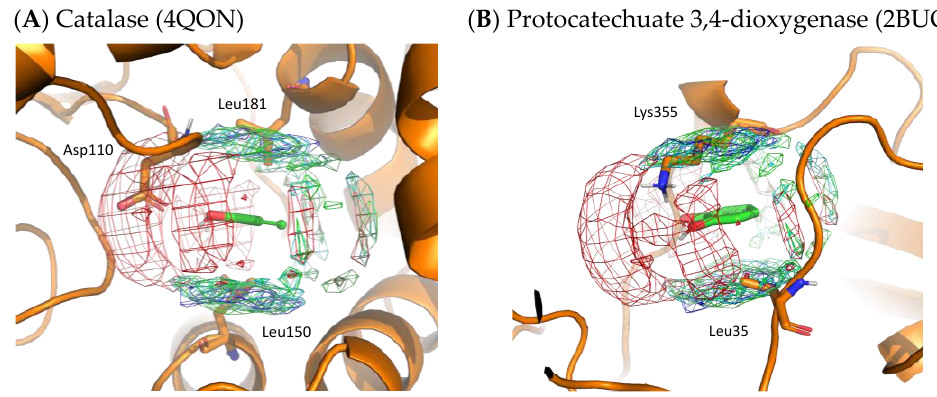
Figure 9. X-ray structures with the residue interaction profile of catechol obtained from MSMD simulation. ( A ) Catalase with catechol (PDBID: 4QON); ( B ) protocatechuate 3,4-dioxygenase with catechol (PDBID: 2BUQ). Green, cyan, gray, blue, and red meshes indicate profiles of hydrophobic, hydrophilic, aromatic, basic, and acidic residues, respectively.